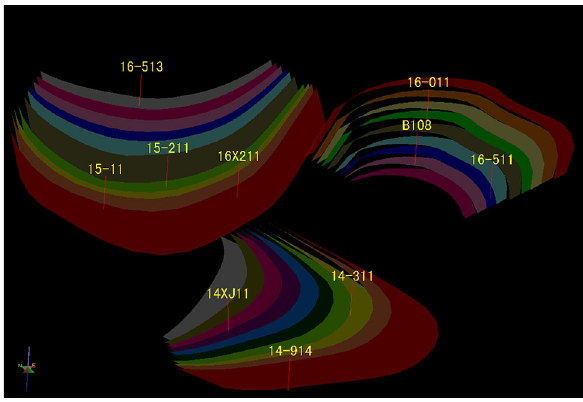
Fig. 9 Establishment of 3D lateral accretion surface model combined with well data